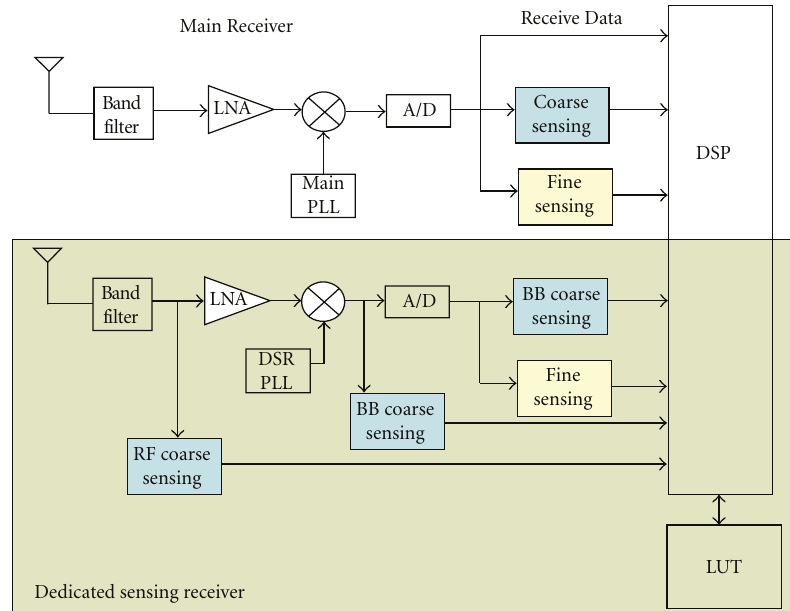
Figure 1: Proposed block diagram.